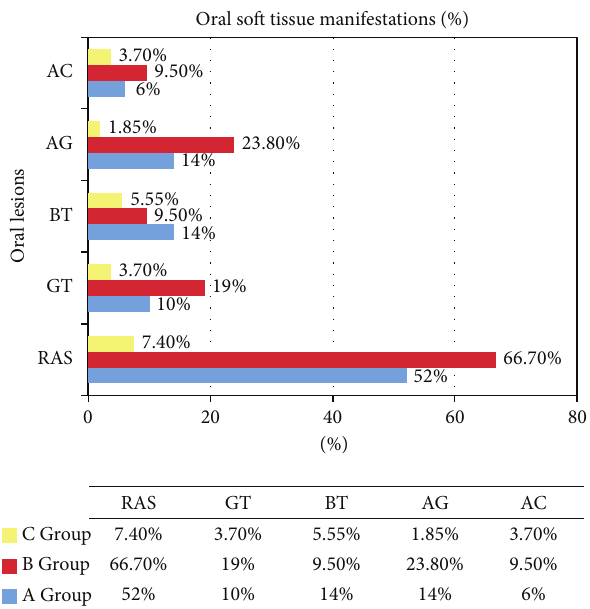
Figure1:Oralsofttissuemanifestationsinascertainedandpotential coeliac patients and in healthy subjects.